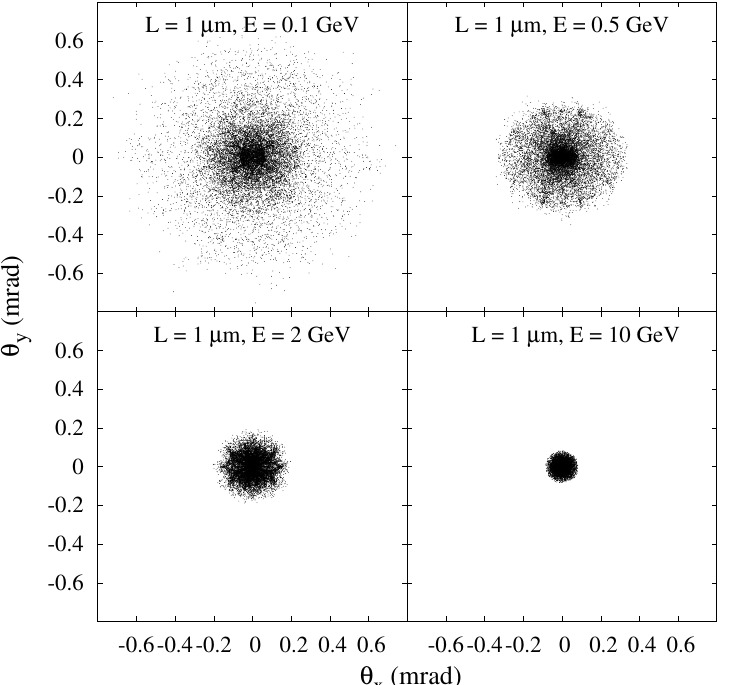
Figure 8. The angular distributions of protons channeled in the radially deformed DWNTs(10, 0)@(5, 0) for different proton energies: (left top) E = 0.1 GeV; (right top) E = 0.5 GeV; (left down) E = 2 GeV; (right down) E = 10 GeV, respectively. The radial strain is η = 0.1 and nanotube length is L = 1 µ